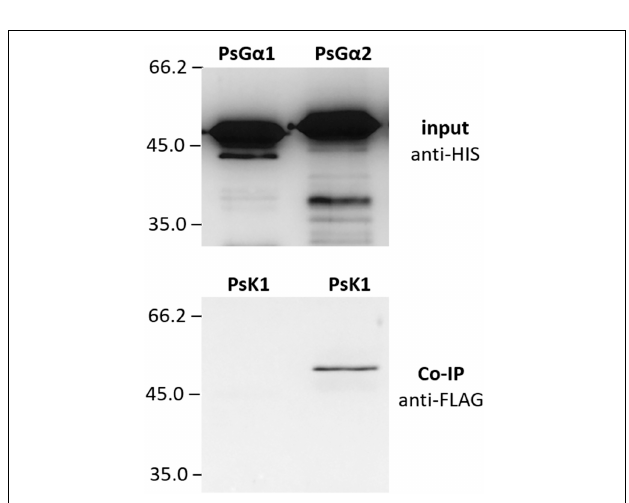
FIGURE 6 | The result of co-immunoprecipitation between LysM-RLK PsK1 kinase domain and PsG alpha 1 and PsG alpha 2 subunits. LysM-RLK PsK1 interacts with PsG alpha 2, but does not interact with PsG alpha